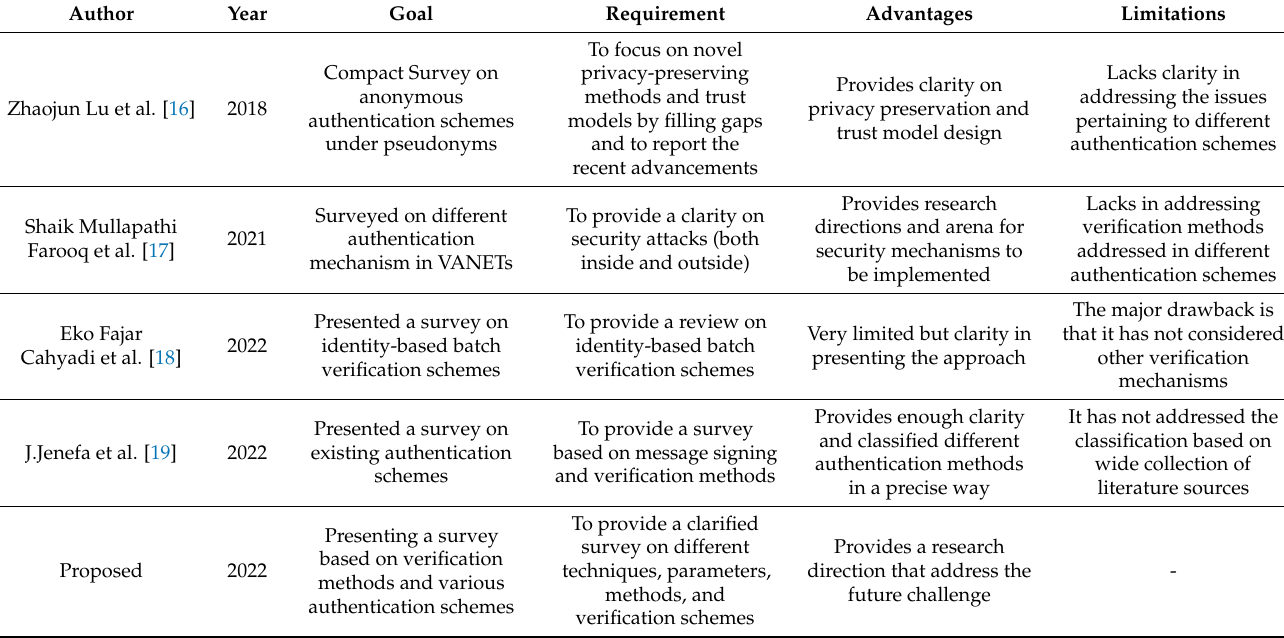
Table 1. Comparison with existing surveys.